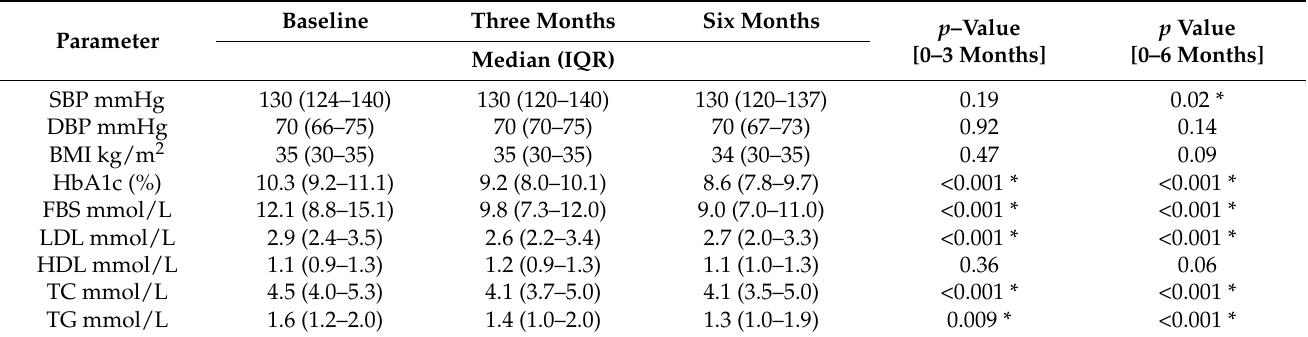
Table 2. Change of median (IQR) values of HbA1c and other cardiovascular risk parameters before and after education intervention among participants.